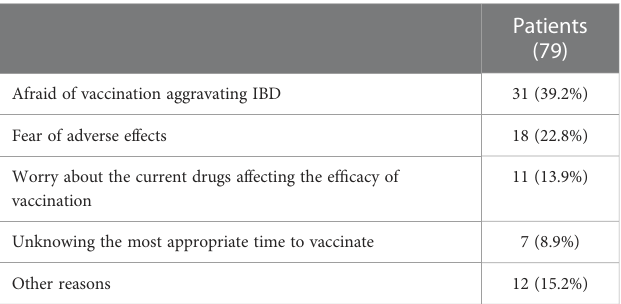
TABLE 2 Main rejecting reasons of the COVID-19 vaccine in the refusals.